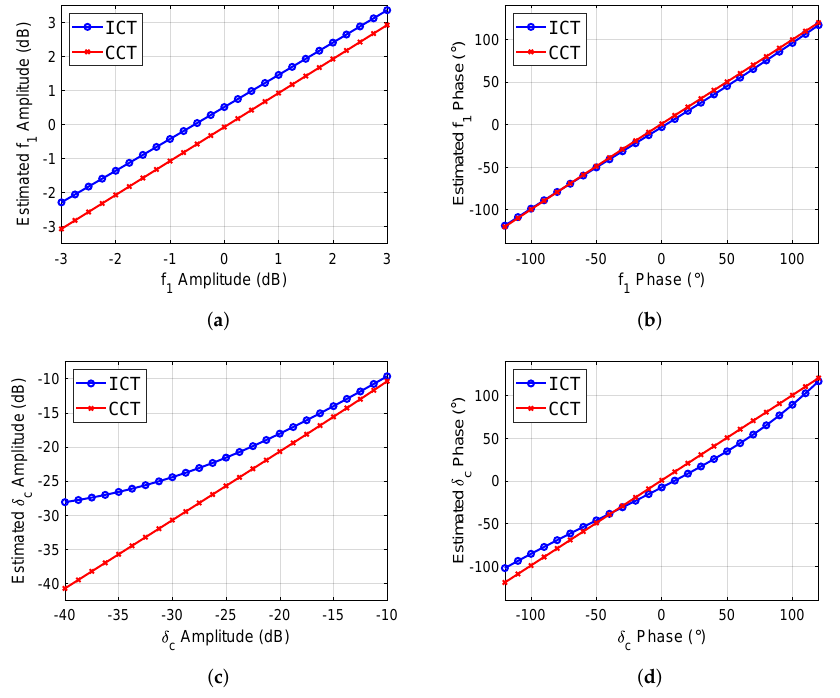
Figure 9. Simulation of distortion parameters estimation when the crosstalk level is relatively high ( | δ 1 | = − 20dB, | δ 2 | = − 25dB). ( a ) | f 1 | (dB). ( b ) arg { f 1 } ( ◦ ) . ( c ) | δ c | (dB). ( d ) arg { δ c } ( ◦ )